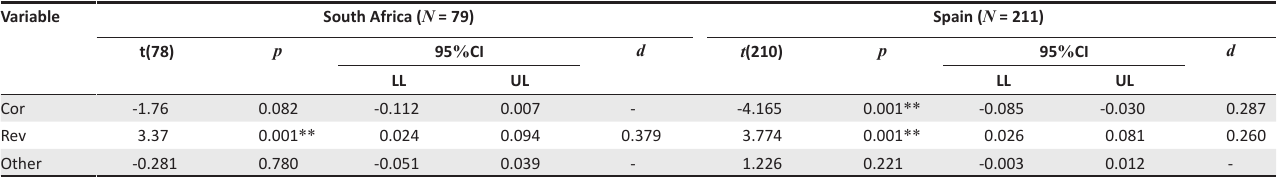
TABLE 4: Contrasts for differences depending on the syntactic obstruction. Variable